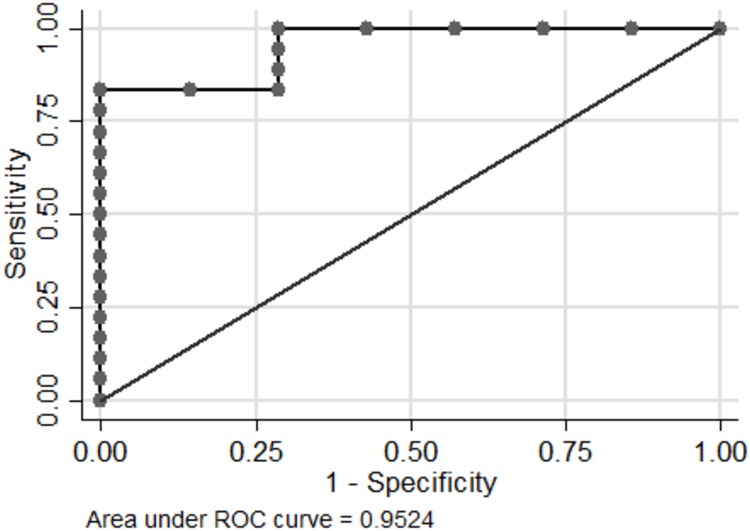
Receiver operating characteristic (ROC) curve generated from the median difference of extracellular microvesicle (EV) let-7g-5p delta_levels* in plasma and response to MAPK-inhibiting treatment in 25 patients with metastastic cutaneous malignant melanoma.The diagonal represents the line of no-discrimination. Points above this line indicate a good classification results (better than random) and below this line a poor classification results (worse than random). The area under the ROC curve is an estimate of the overall accuracy of the test, a value of 0.9524 indicates excellent accuracy. * The difference in EV let-7g-5p levels before (BT) and during treatment (DT).